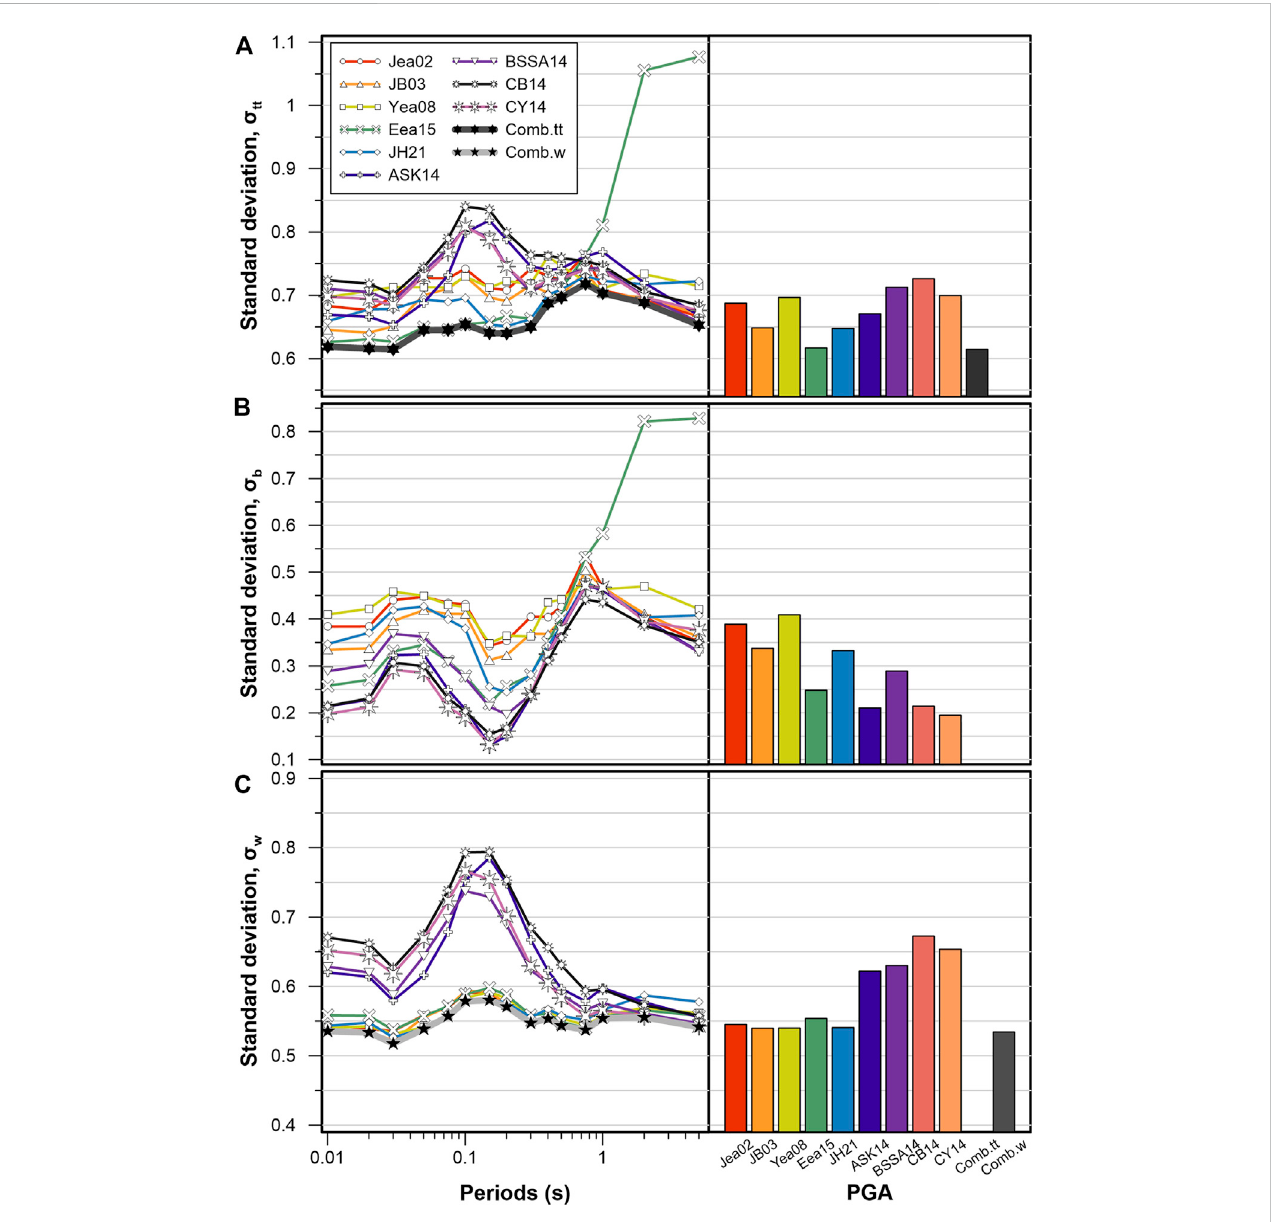
FIGURE 5 Standard deviation of (A) total residuals, (B) between-event residuals, and (C) within-event residuals for nine individual GMMs and combined GMMs suggested in this study.